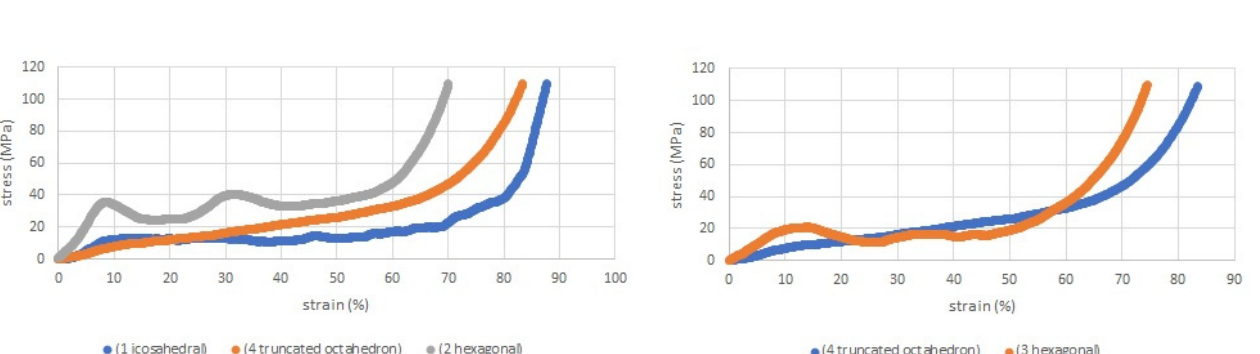
Figure 10. Al open cell manufactured foams: ( a ) icosahedral; ( b ) hexagonal; ( c ) hexagonal; ( d ) truncated octahedral.